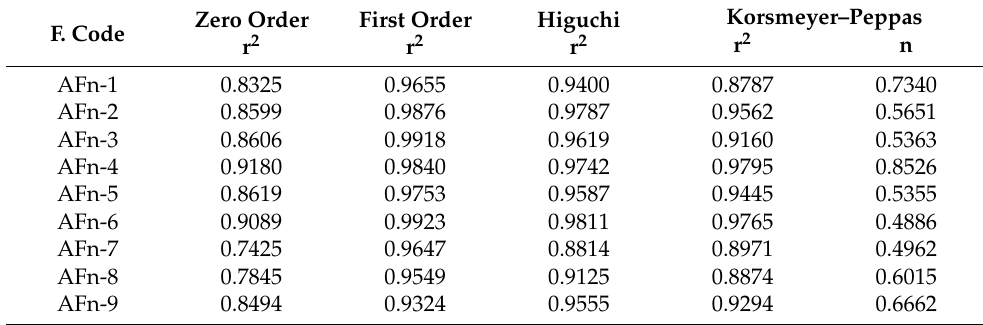
Table 2. Kinetic modeling release of TP from ASPA-pAMPS microgels. F.